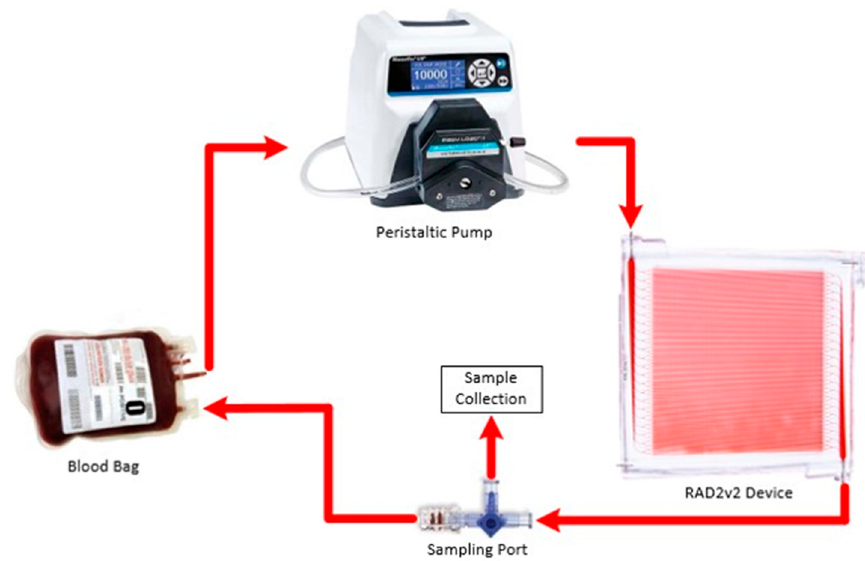
Figure 4. Schematic of experimental circuitry and monitoring setup. Blood is stored in the blood bag and flows through the Pump, RAD2v2 oxygenator then back to the blood bag. Flowmeters are clamped onto the tubing pre and post RAD2v2 oxygenator (F1 and F2). Pressure monitoring through a Luer port pre and post RAD2v2 oxygenator (P1 and P2).